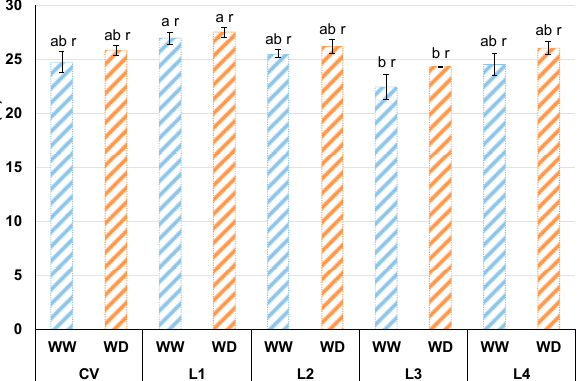
Figure 5. Protein content (%) in Portuguese cowpea grains of a commercial variety (CV) and four landraces, L1, L2, L3, and L4, obtained under well-watered (WW) and water deficit (WD) conditions. The values correspond to means ( n = 3). Different letters mean significant differences between varieties (a, b, c) and between treatments for each variety (r, s). The letters (a) and (r) correspond to the highest values. (ANOVA, p <